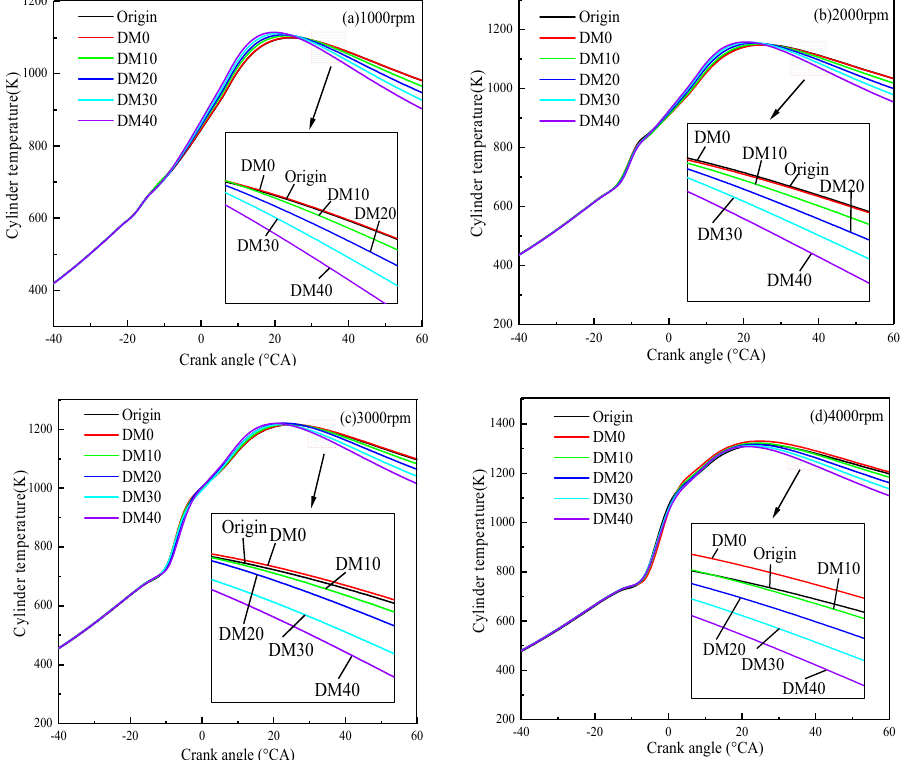
However, the cylinder temperature of DM0 is the highest in the later stage of combus- tion, followed by DM10, DM20, DM30, and DM40. This is due to the calorific value of Figure 4. Effect of different ratios of methanol-diesel mixtures on engine in-cylinder pressure at different speeds. methanol being lower than that of diesel, which generates less heat and makes the cyl- inder temperature lower. Figure 5a–d shows the effect of methanol-diesel mixtures with different ratios on the engine in-cylinder temperature at different speeds. It can be seen that with the increase of the ratio of methanol in the mixed fuel, the overall temperature in the cylinder shows a downward trend. When the engine speed is 2000 rpm, the maximum cylinder tempera- ture of DM0 is 1147.15 K, and the maximum cylinder temperatures of DM10, DM20, DM30, and DM40 are 1150.26 K, 1153.18 K, 1156.17 K, and 1157.2 K, respectively. This is because the high oxygen content of methanol promotes the combustion of fuel in the cylinder at the early stage of combustion, which makes the cylinder temperature rise.